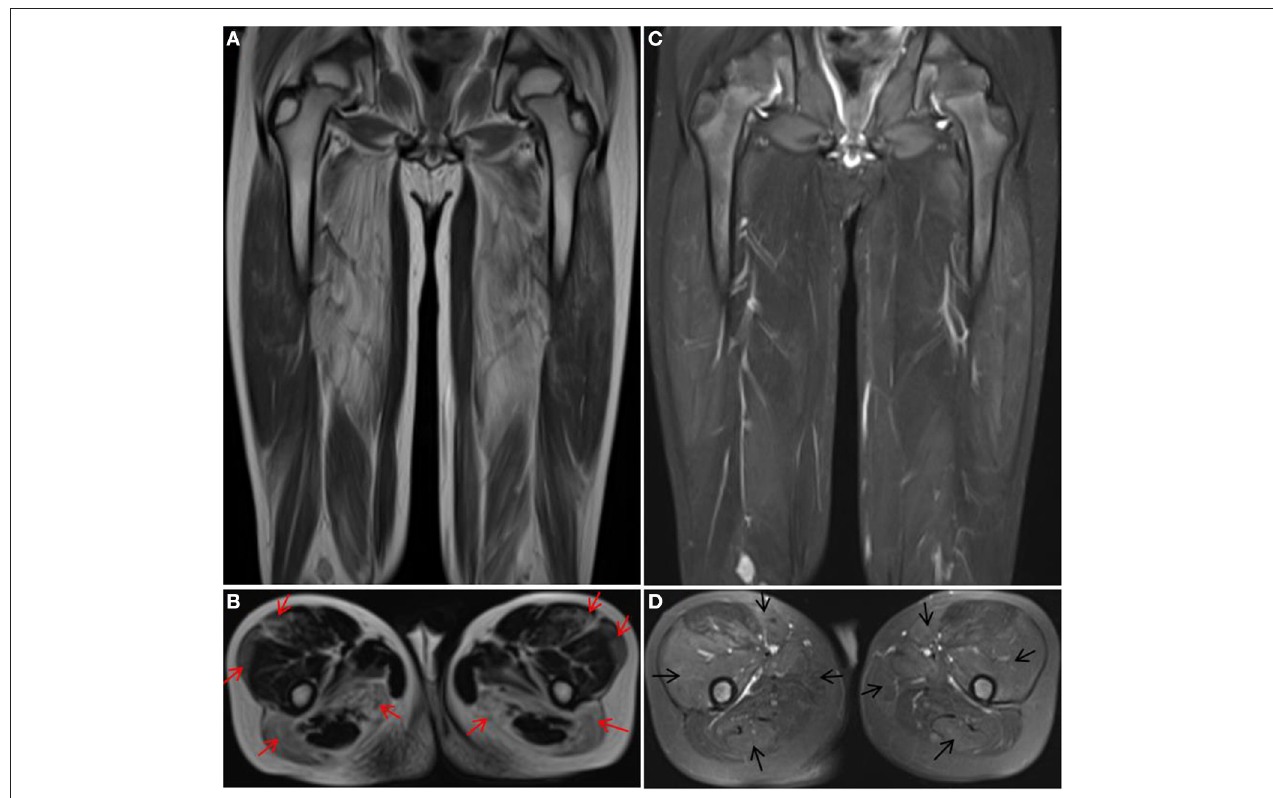
FIGURE 1 | Muscle MRI of case 1. T1 (A,B) showed obvious fat infiltration in thigh muscles, most notably in the vastus lateralis, rectus femoris, biceps femoris, and semimembranosus muscles (red arrow), but the fat infiltration in the vastus intermedius, sartorius, gracilis, and semitendinosus muscles was mild. T2 (C,D) showed obvious inflammation edema in the muscles with mild fat infiltration (black